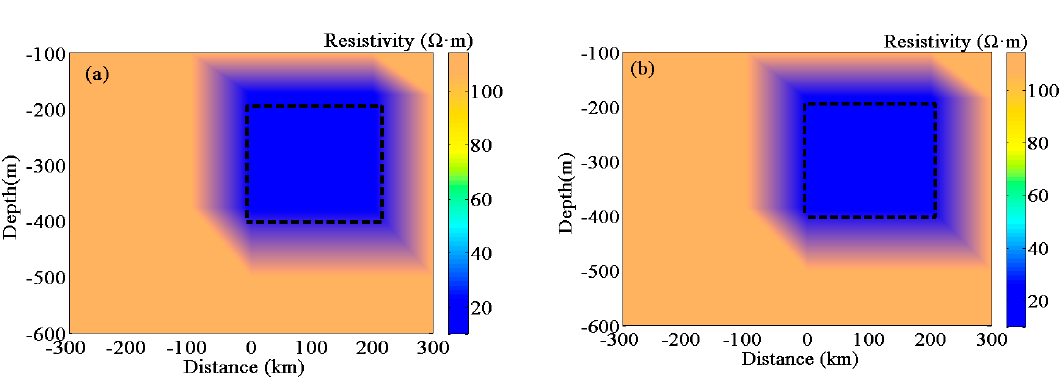
Figure 19. Depth imaging of the 3D polarization model with 50 Hz power frequency noise (( a ) traditional skin depth formula; ( b ) generalized skin depth for polarized porous media).